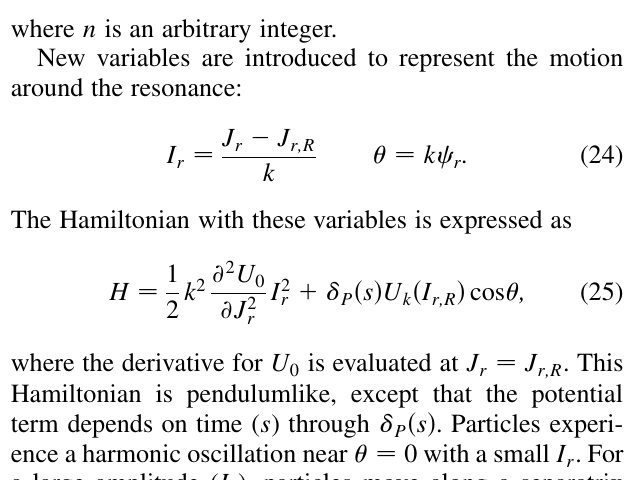
FIG. 4. (Color) Emittance growth for the model with 2 degrees of freedom for various tune shift parameters, (cid:12) (cid:5) 0 : 06 ; 0 : 13 ; 0 : 27 ; 0 : 38